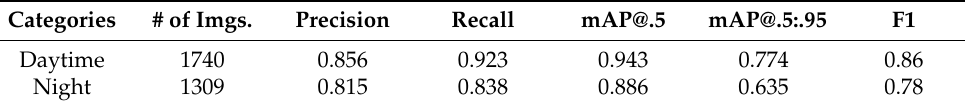
Table 5. Comparison of the recognition performance in different amounts of light.